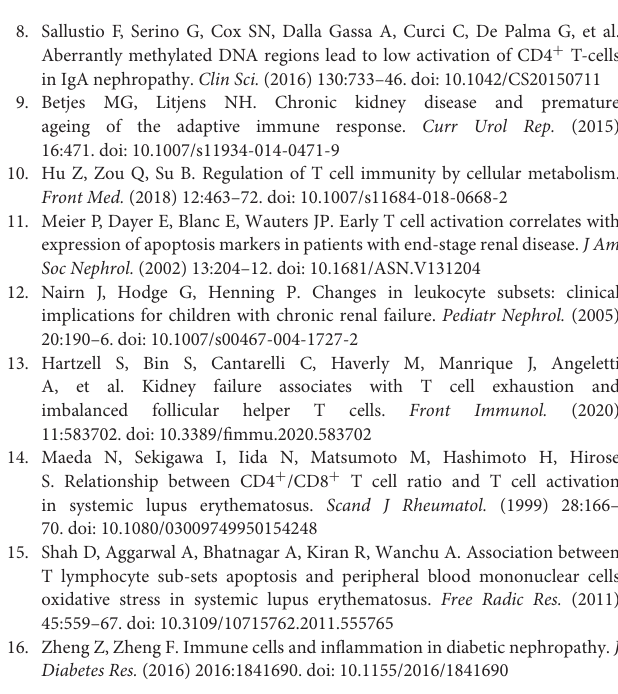
Supplementary Table 2 | The basic characteristics of the included CKD patients according to infection. Supplementary Table 3 | Infection of normal and low level T lymphocyte